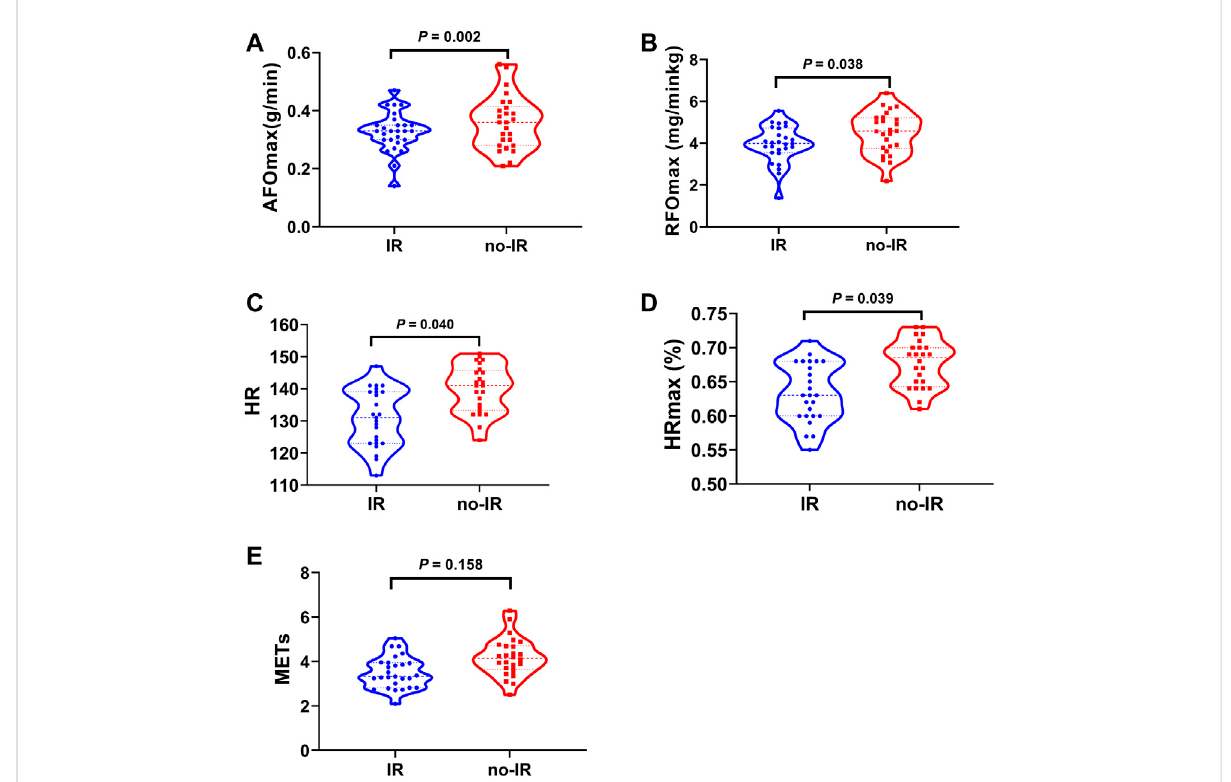
FIGURE 4 FatOxidationandFATmaxinIRandno-IRgroups.ViolinplotoffatoxidationcharacteristicsbetweenIRandno-IR group. (A) :Absolutemaximal fat oxidation rate (AFOmax) between IR and no-IR groups; (B) : Relative maximal fat oxidation rate (RFOmax) between IR and no-IR groups; (C) : FATmax(HR)betweenIRandno-IRgroups; (D) :FATmax(HRmax%)betweenIRandno-IRgroups; (E) :FATmax(METs)betweenIRandno-IRgroups.